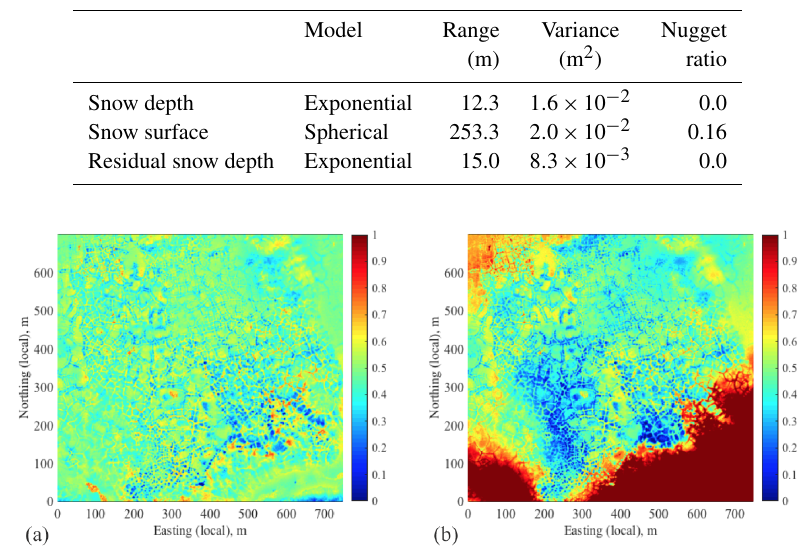
Figure 7. The estimated mean snow depth across the site (in meters) based on (a) the proposed Bayesian method including the correlation to microtopography and (b) the kriging-based interpolation of the snow surface. The spatial extent is the same as Fig.